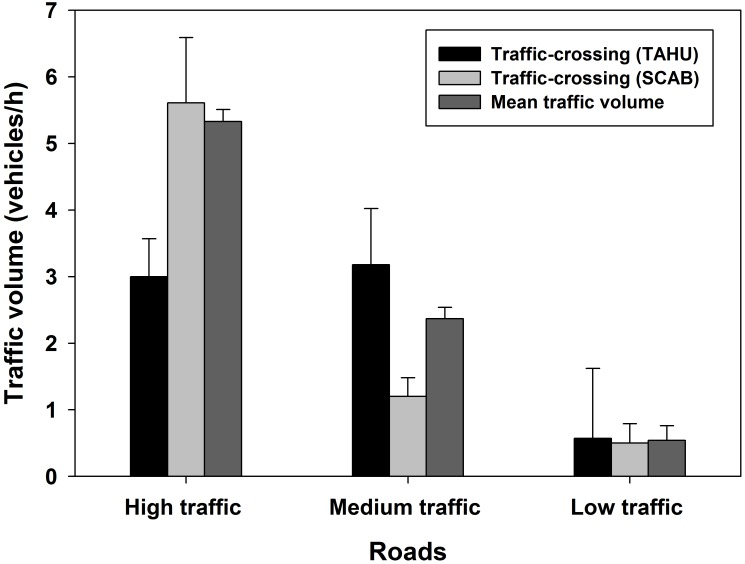
Traffic volume during road crossings by Mt. Graham red squirrel (Tamiasciurus hudsonicus grahamensis, MGRS) and Abert’s squirrels (Sciurus aberti, SCAB), Mt.Graham, Arizona, USA on Mt. Graham, Arizona, USA.